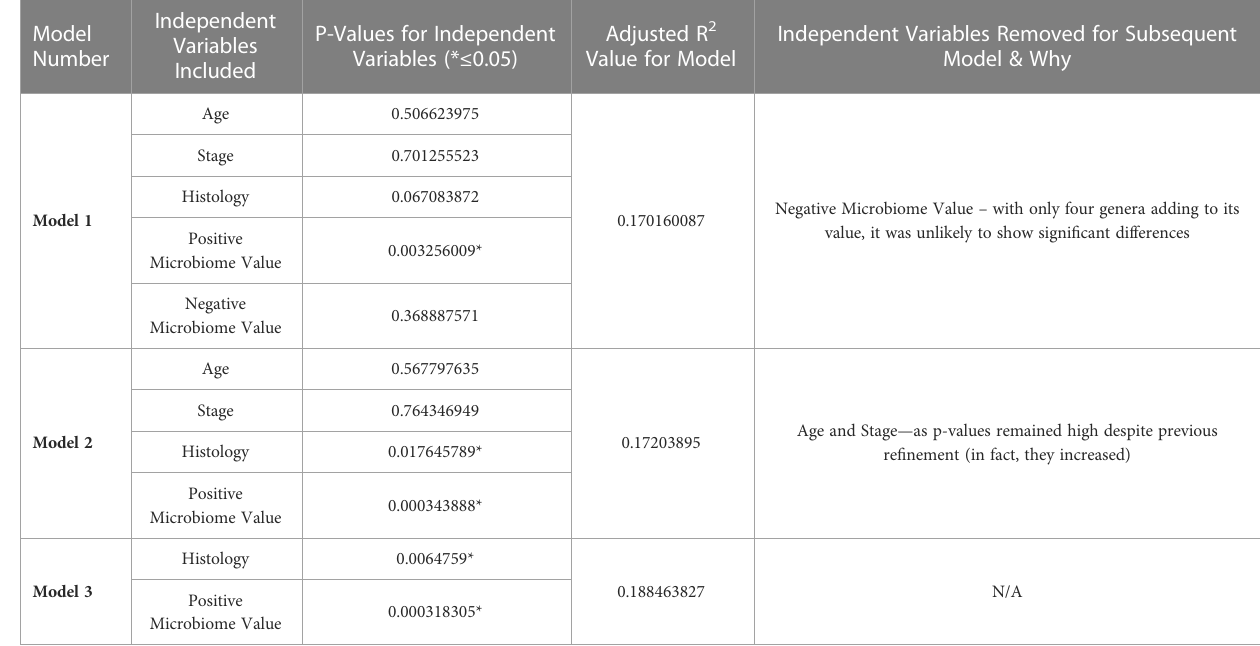
TABLE 1 Multiple linear regression model and iterations.